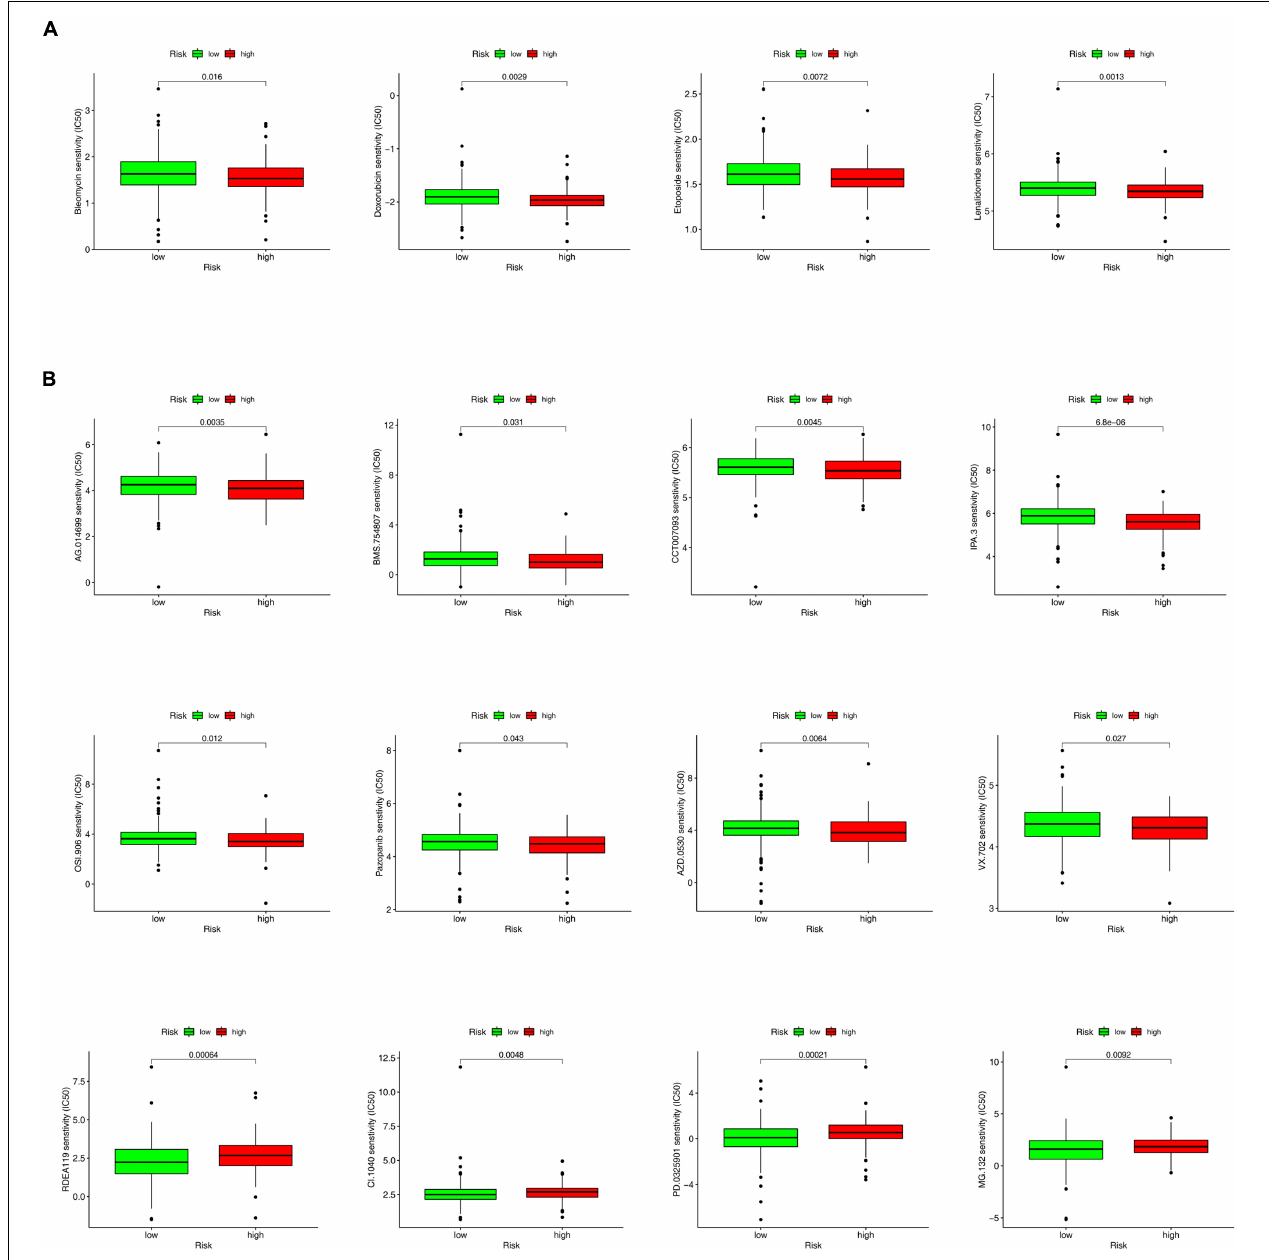
FIGURE 8 | The box charts for differences in IC50 for antitumor drugs and kinase inhibitors between the high- and low-risk groups. (A) Chemotherapeutics such as bleomycin ( p = 0.016), doxorubicin ( p = 0.0029), etoposide ( p = 0.0072), and lenalidomide ( p = 0.0013) exhibited a lower IC50 in high-risk groups (A) . (B) Kinase inhibitors, including AG.014699 ( p = 0.0035), BMS.754807 ( p = 0.031), CCT007093 ( p = 0.0045), OSI.906 ( p = 0.012), Pazopanib ( p = 0.043), AZD.0530 ( p = 0.0064), VX.702 ( p = 0.027), and IPA.3 ( p < 0.001) showed a lower IC50 in high-risk groups. However, kinase inhibitors such as RDEA119 ( p = 0.00064), CI.1040 ( p = 0.0048), PD0325901 ( p = 0.00021), MG.132 ( p = 0.0092) showed a lower half inhibitory centration (IC50) in low-risk group (B)